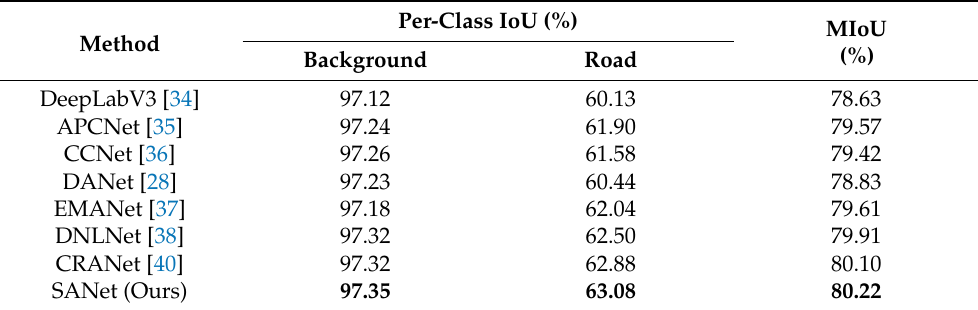
Table 9. Comparison with other methods based on the CHN6-CUG dataset. Data in bold are the best results.